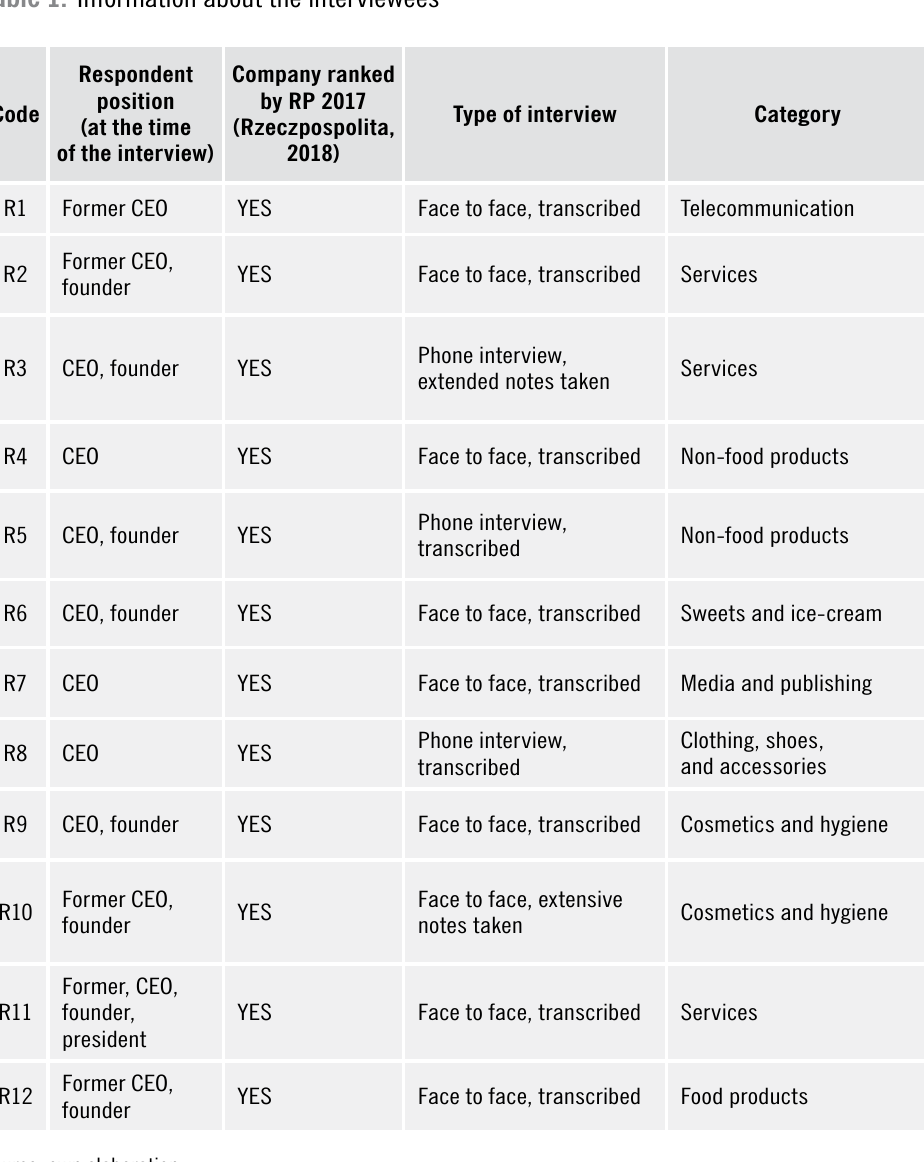
Table 1. Information about the